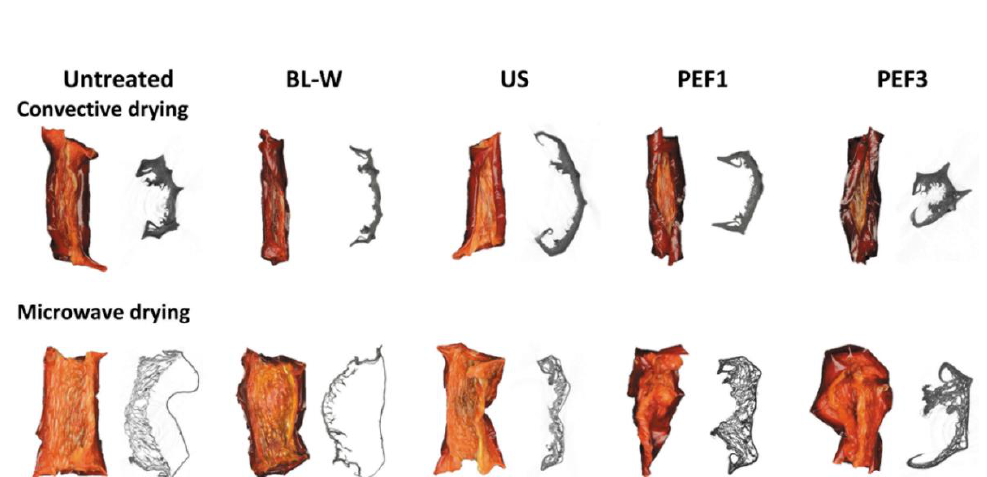
Figure 2. Photos (in color) and binarized μ CT images (black-and-white color) of convective (CV) and microwave – convective (MV) dried red bell pepper without (untreated) and subjected to thermal or non-thermal treatment prior to drying.